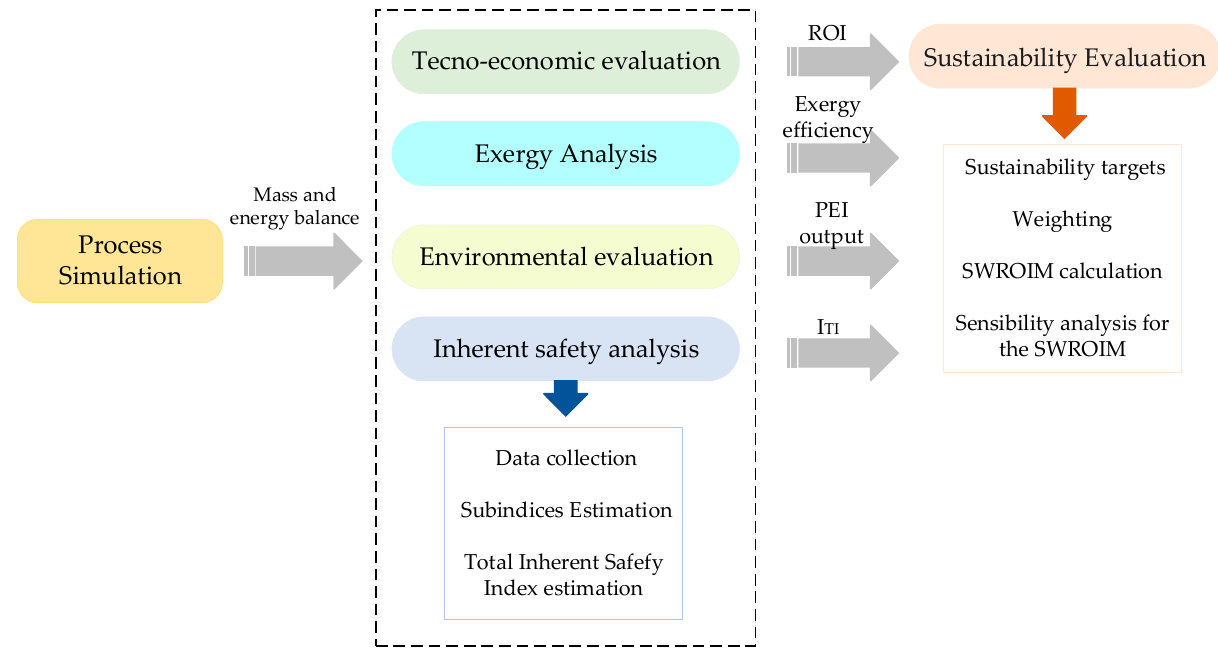
Figure 1. Schematic representation of the methodology.